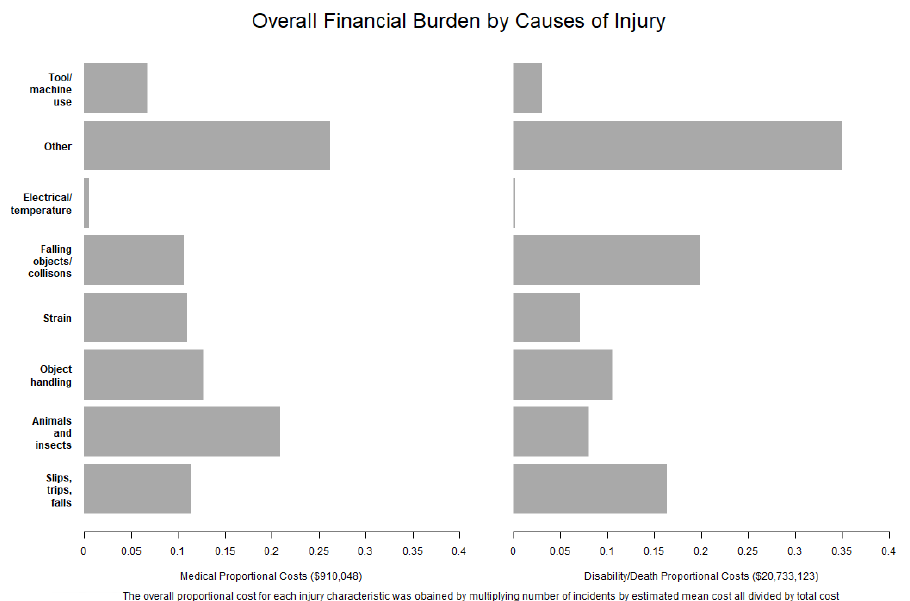
Figure 2. Overall financial burden by the causes of injury.